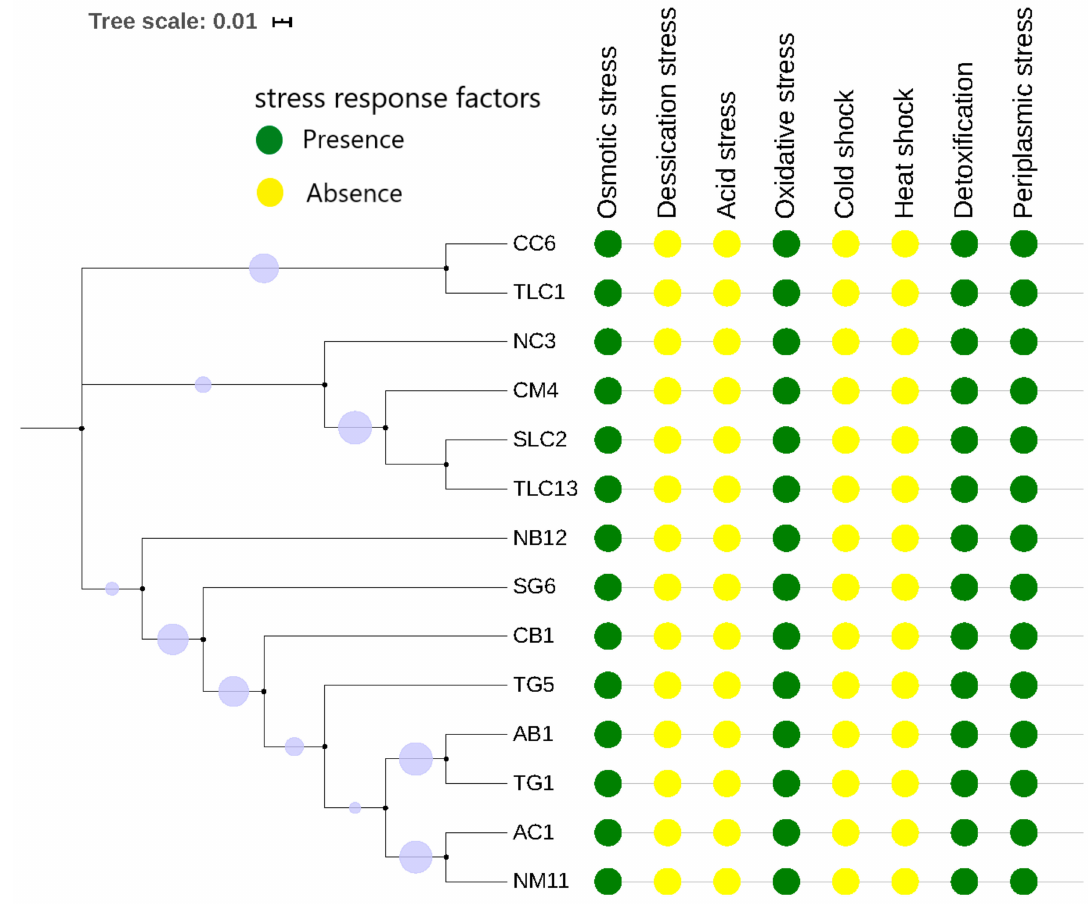
Figure 3. A colour gradient generated phylogenetic tree of distribution of stress response factors across the E. coli isolates ( n = 14). The green colour represents the presence of the gene, and the yellow colour represents the absence of the gene. Conserved stress response factors (osmotic stress, oxidative stress, detoxification, and periplasmic stress) were found in all the strains irrespective of their sources, area, and sequence